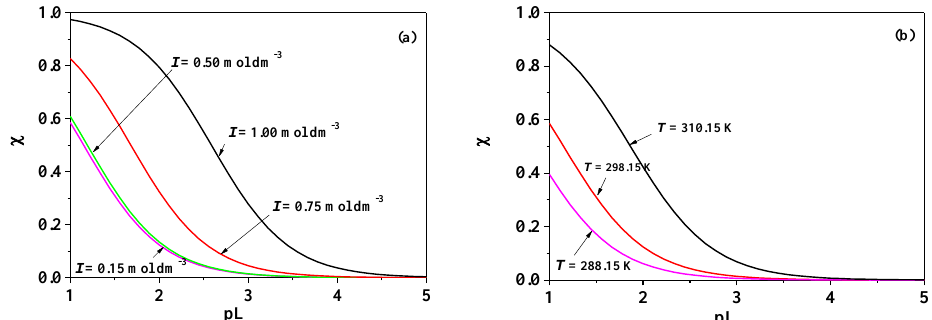
Figure 8. Sequestering diagram of dopamine towards Ca 2+ . ( a ) T = 298.15 K, pH = 7.4 and different ionic strengths; ( b ) I = 0.15 mol dm −3 , pH = 7.4 and different temperatures. pL 0 . 5 values: ( a ) 1.15 ( I = 0.15 mol dm −3 ) < 1.19 ( I = 0.50 mol dm −3 ) < 1.68 ( I = 0.75 mol dm −3 ) < 2.58 ( I = 1.0 mol dm −3 ). ( b ) 0.81 ( T = 288.15 K) < 1.15 ( T = 298.15 K) < 1.86 ( T = 318.15 K).